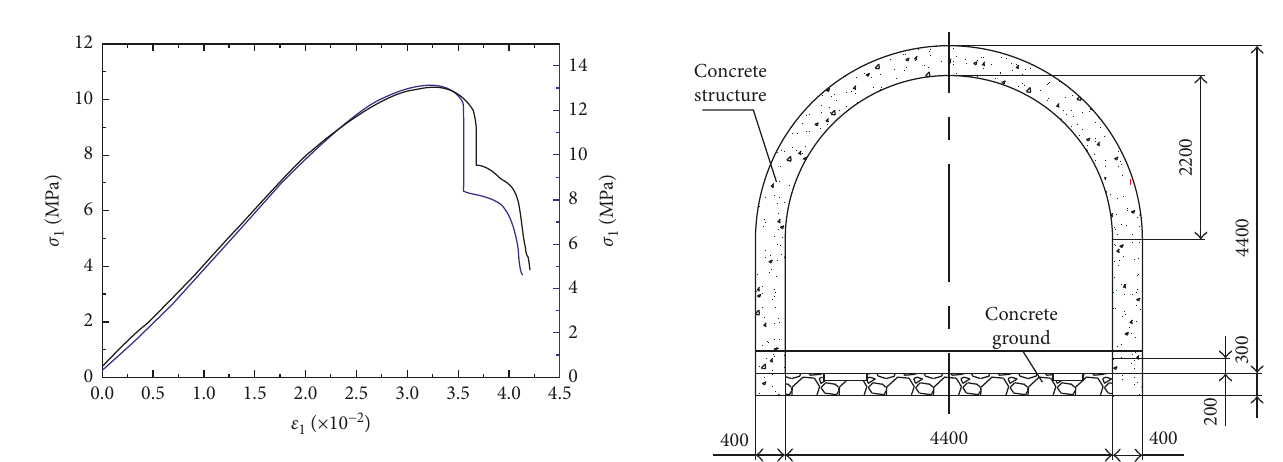
Figure 1: Stress-strain curves of the solidification Table 3: Main properties of the cured material.